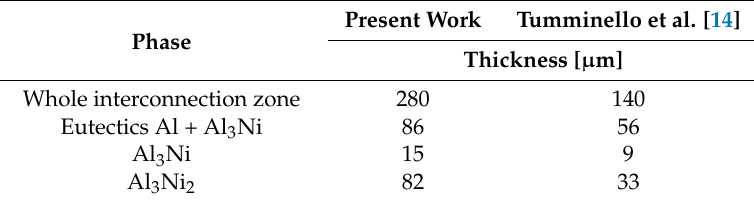
Table 2. Average thickness of the whole joint and particular intermetallic phases—both sides of the joint. Phase Present work Tumminello et al. [14] Thickness [ μ m]